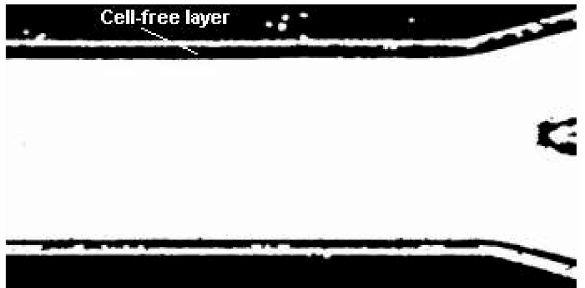
Figure 16. The obtained image from the automatic method. The area to take the data is defined by the user selecting the wall of the channel and the limit area from the cell-free